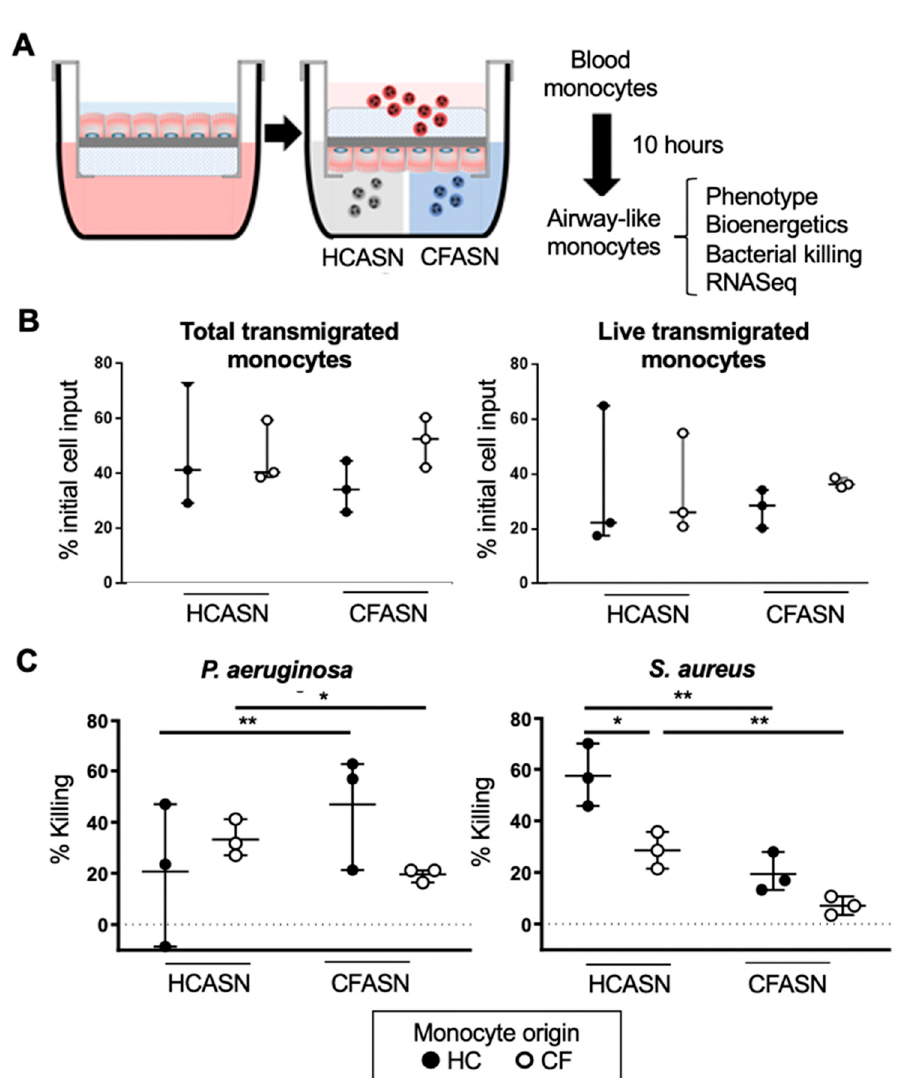
Figure 1. Yield and bactericidal activity of transmigrated monocytes in our model. ( A ) Our model enables transmigration of blood monocytes from healthy control (HC) or cystic fibrosis (CF) donors into HC or CF airway supernatant (HCASN or CFASN, mimicking recruitment into HC or CF airways, respectively), after which airway-like monocytes are analyzed functionally and transcriptionally. ( B ) Yields of total transmigrated monocytes (left) and live transmigrated monocytes (right) are shown as % of initial blood monocyte input. ( C ) Bactericidal activity of transmigrated monocytes against P. aeruginosa (left) and S. aureus (right) is shown as % of initial bacterial input. Statistics: Mann–Whitney test for different monocytes (HC vs. CF) recruited to the same ASN (HC or CF) and Wilcoxon signed rank test for the same monocytes (HC or CF) recruited to different ASN (HC vs. CF). * and ** mark p < 0.05 and p < 0.01, respectively. n = 3 per condition. Non-significant differences are not indicated.